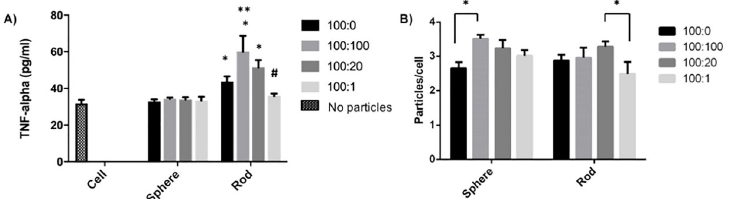
Fig 4. Effect of IgG ligand density and presentation on shaped particles. (A) TNF- α produced by J774 macrophages at each ligand density when presented on spherical or rod shaped particles. (B) Quantitative analysis of total particles associated with macrophages, including attached and internalized, at each ligand density for spheres or rods. Error bars indicate averages +/- standard deviation of n = 3 and � denotes p < 0.05 between corresponding spherical and rod shaped groups. �� denotes p < 0.05 between 100:100 and 100:0 rod shaped groups and # denotes p < 0.05 between 100:1 and 100:100 or 100:20 rod shaped groups as determined by two-way ANOVA with Tukey’s multiple comparison test.